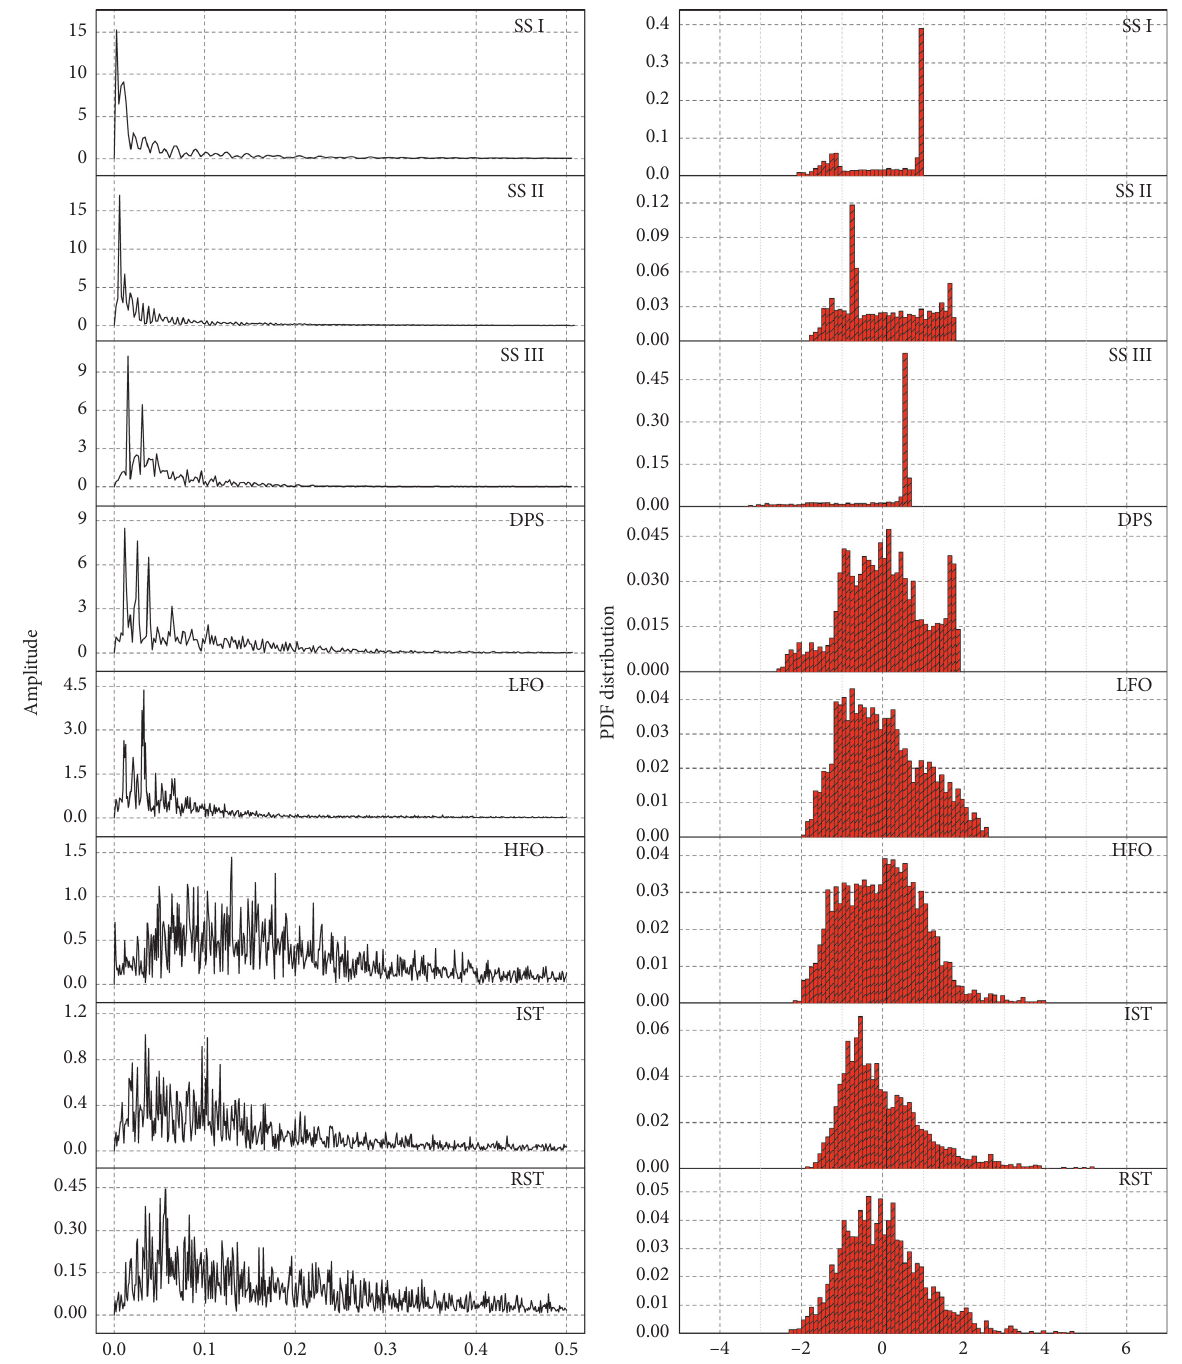
Figure 10: Frequency domain and probability density function characteristics of P